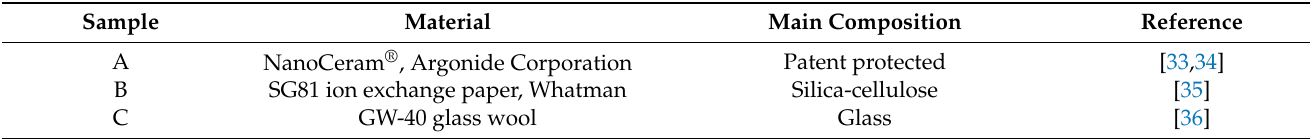
Table 1. Summary of the eight different passive sampler materials used in the